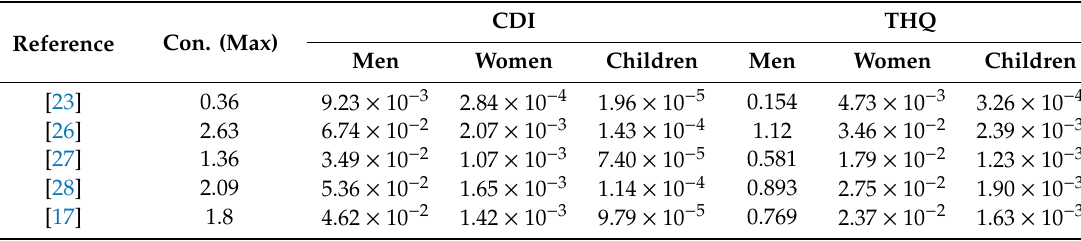
Table 3. Chronic daily intake (CDI, mg/kg/day) and target hazard quotient (THQ) values due to exposure of men, women, and children to fluoride in consumed tea based on 95 percent percentile obtained from Monte Carlo simulations.